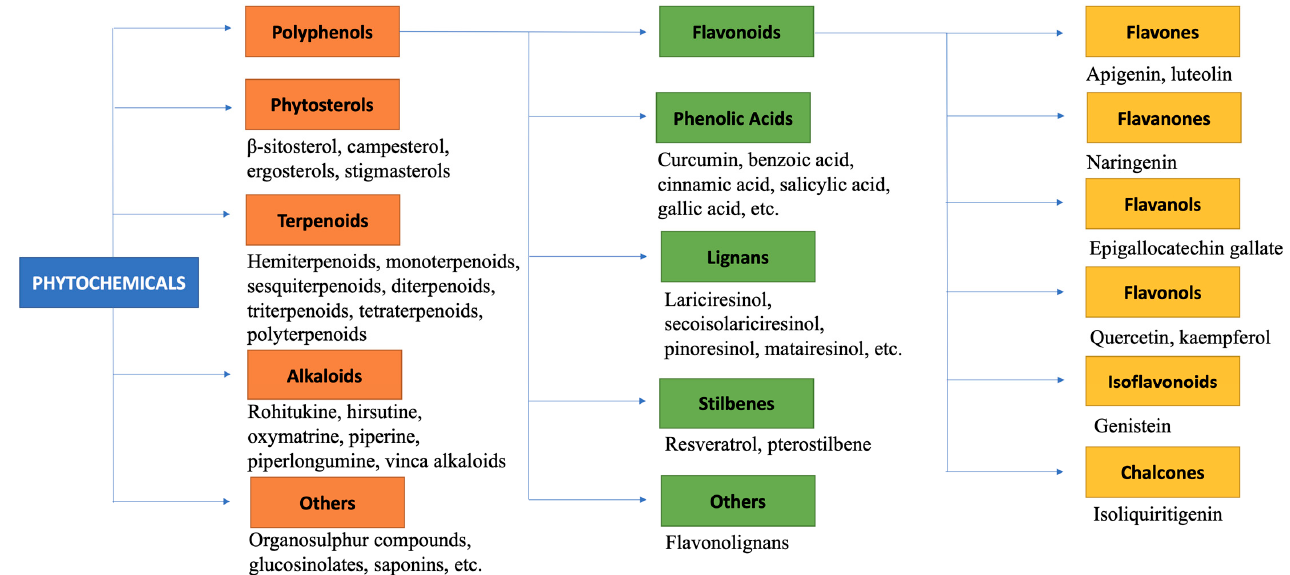
Figure 3. Classification of phytochemicals.